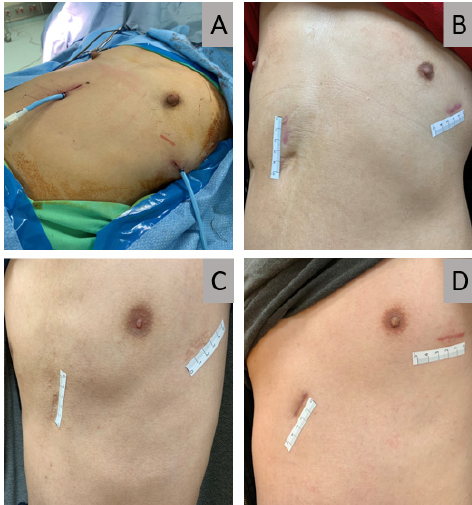
Figure 5. Patients receiving simultaneous uniportal ipsilateral subxiphoid and contralateral inter- costal VATS. ( A ) A patient with equal length of subxiphoid and intercostal incision and drain size. ( B – D ) Postoperative pictures of three different patients with equally long subxiphoid and intercostal incisions three months following surgery. VATS, video-assisted thoracoscopic surgery.